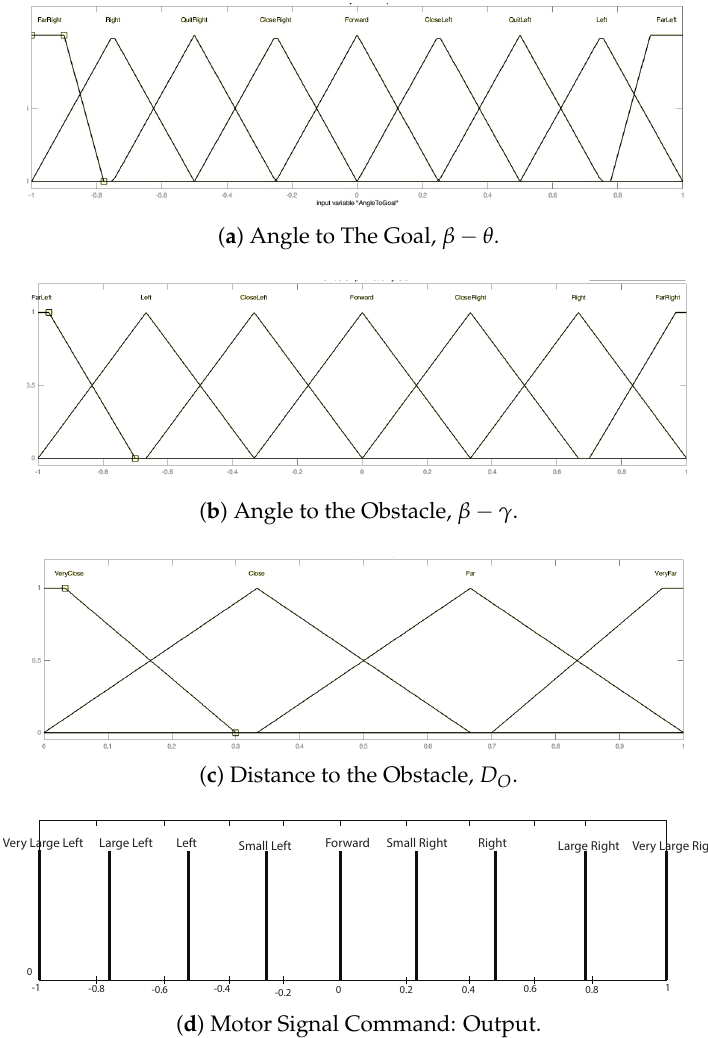
Figure 6. Fuzzy Membership Functions for the Obstacle-Avoidance Controller.